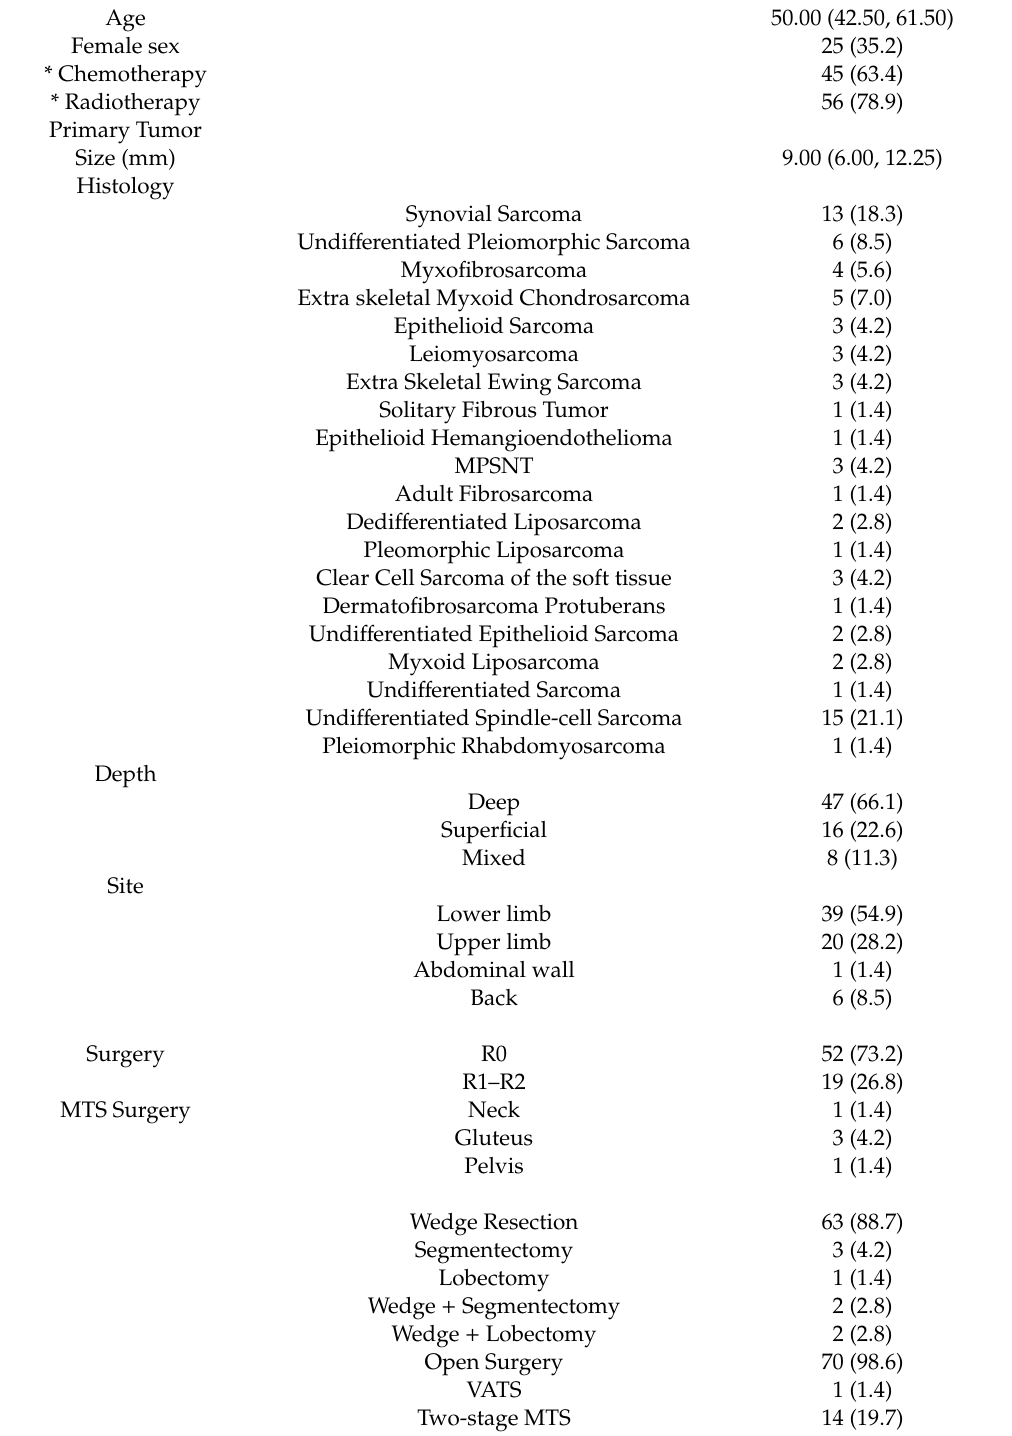
Table 1. Patients and primary tumor characteristics ( n =